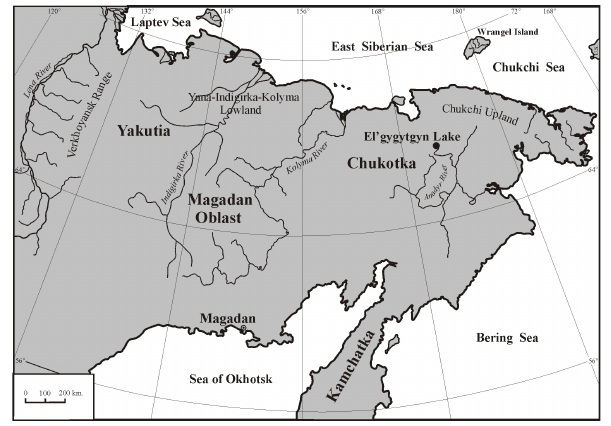
Fig. 1. Map of northeast Siberia showing location of Lake